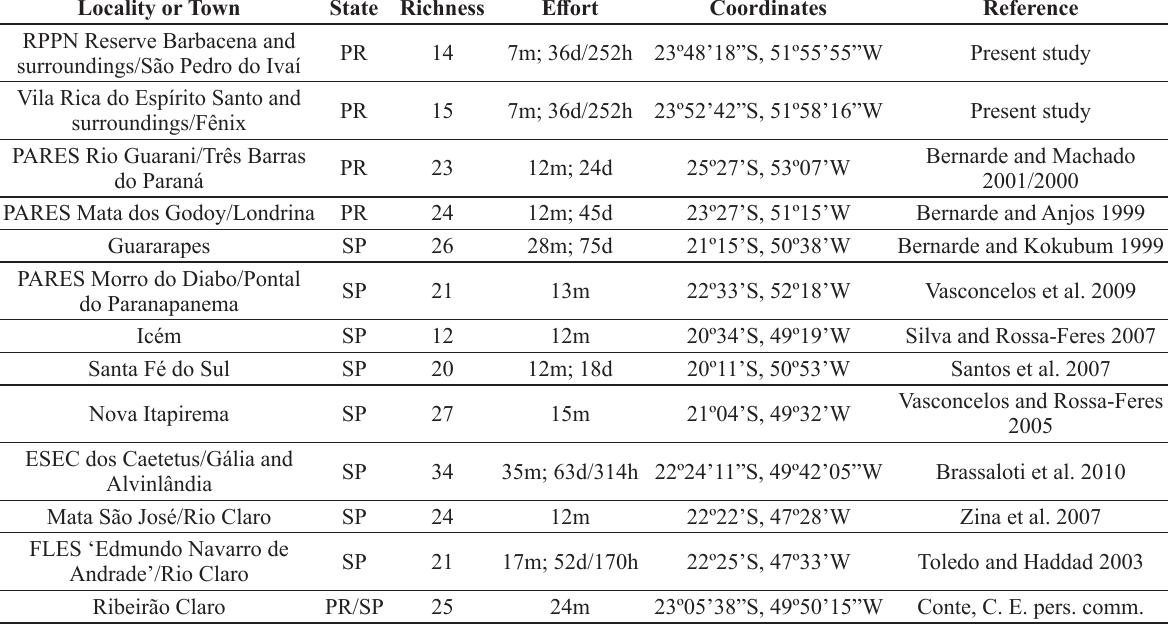
list and description of localities with inventoried anurofauna inserted in the Mesophytic semideciduous Forest considered in this research. RPPN: Reserva Particular do Patrimônio Natural; PARES: Parque Estadual; ESEC: Estação Ecológica; FLES: Floresta Estadual. Sampling effort presented as: months (m); days (d) and hours (h). locality or